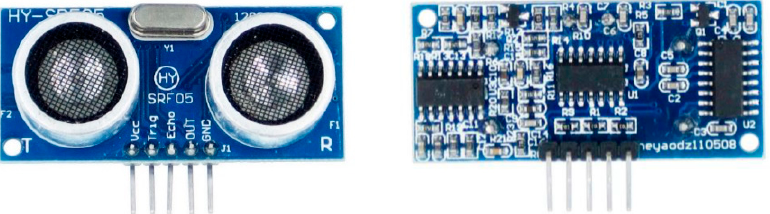
Figure 1. Low-cost ultrasonic distance sensor (HY-SRF05). R and T indicate the receiver and transmitter, respectively.